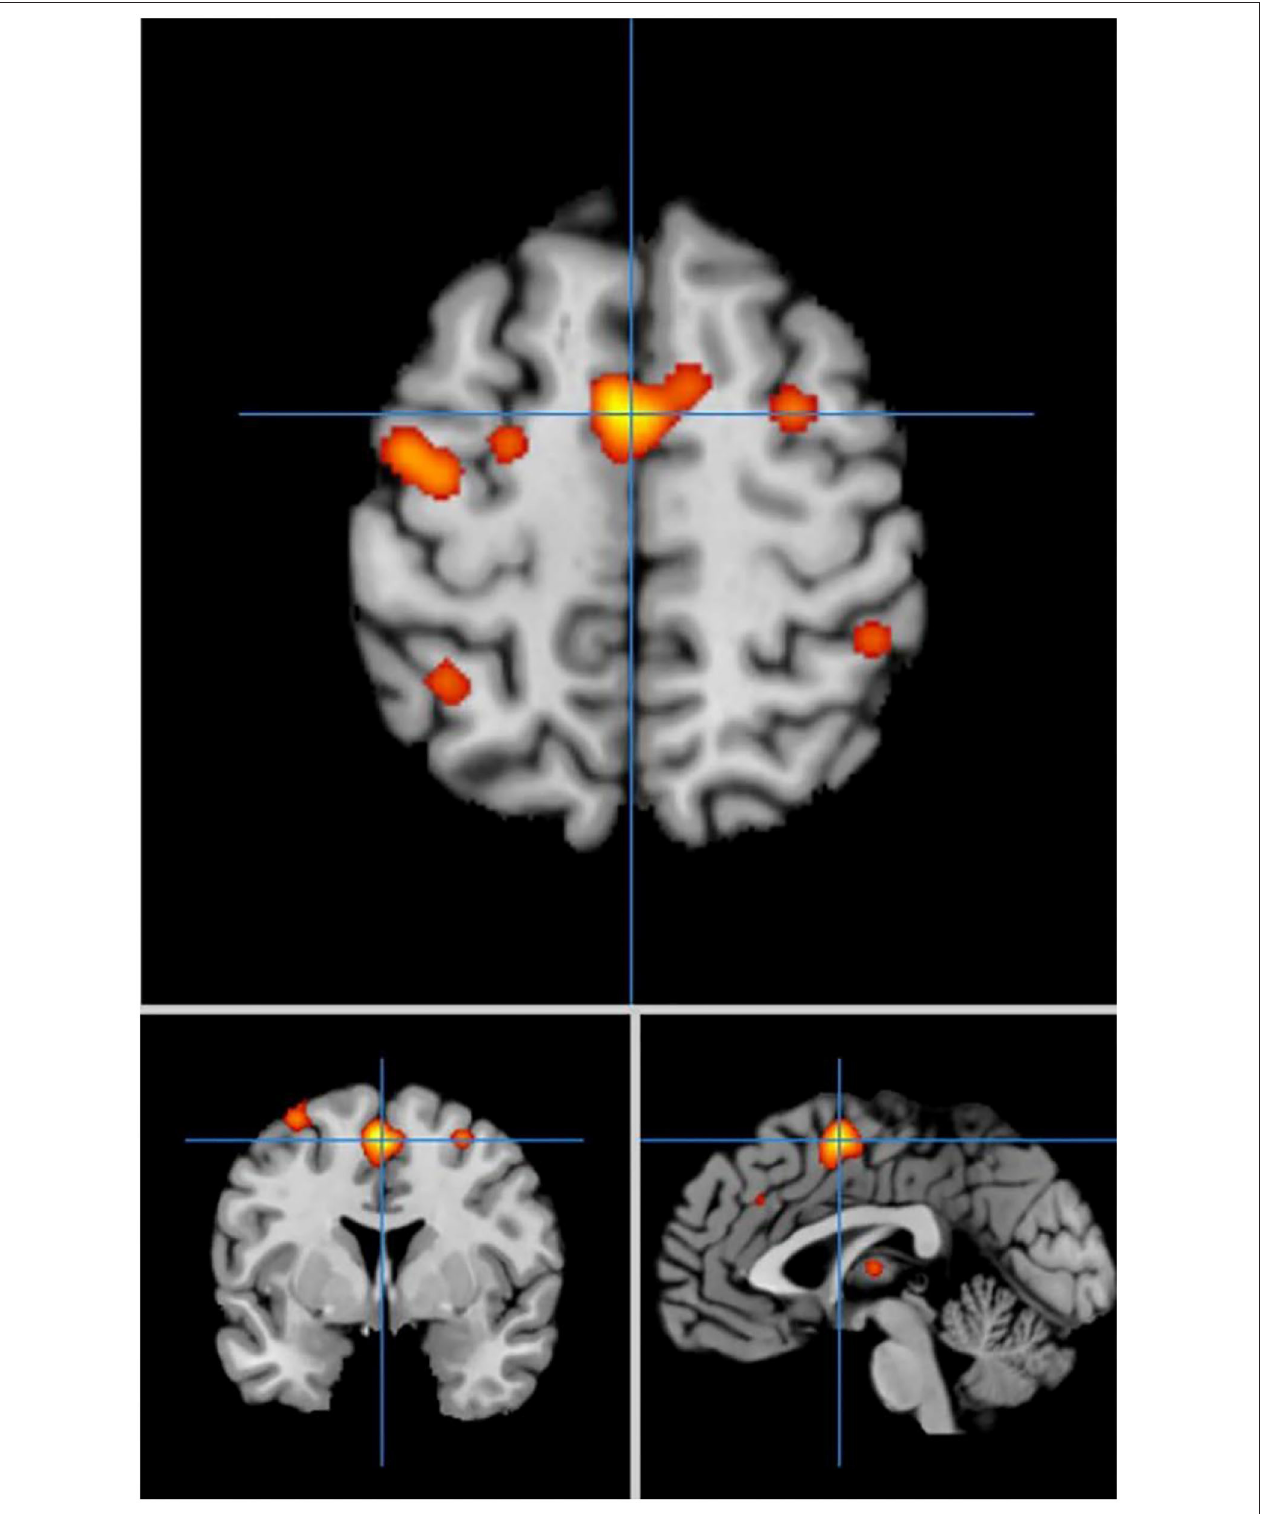
FIGURE 2 | Significant clusters in the ALE meta-analysis in self-priming conditions in the PD patients.